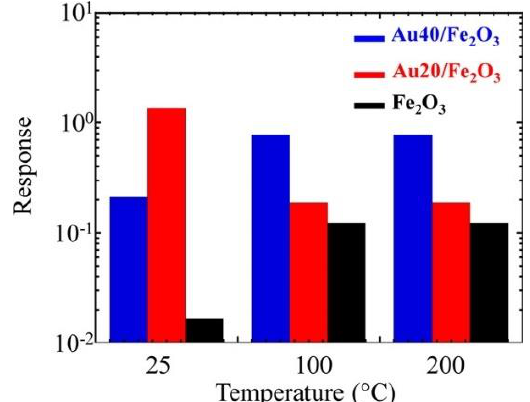
Figure 6. Response to 5 ppm of NO 2 as a function of the sensor working temperature for ε ‒ Fe 2 O 3 and Au/ε ‒ Fe 2 O 3 nanocomposites with different gold contents. Reproduced with permission from [70].